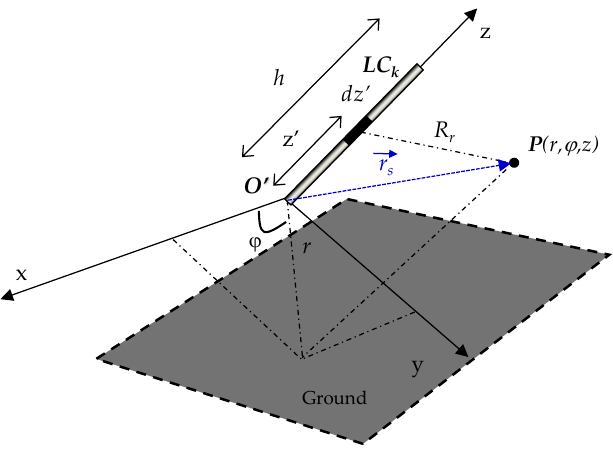
Figure 3. Arbitrarily oriented channel segment.